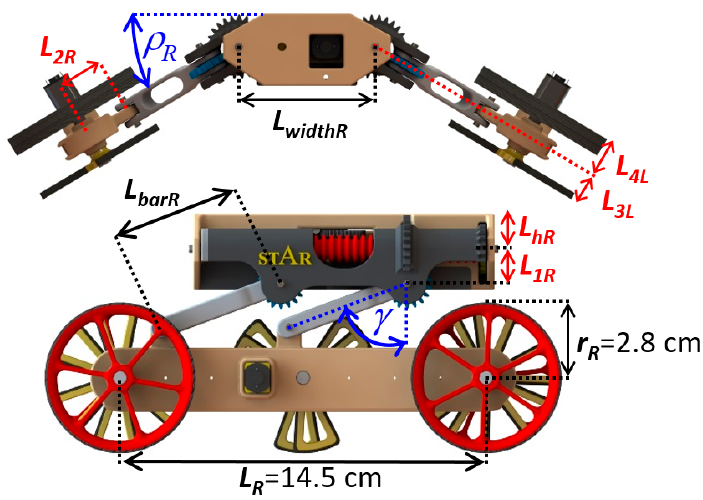
Figure 3. The dimensions of the RSTAR, the child robot. Top—front view; Bottom—side view.